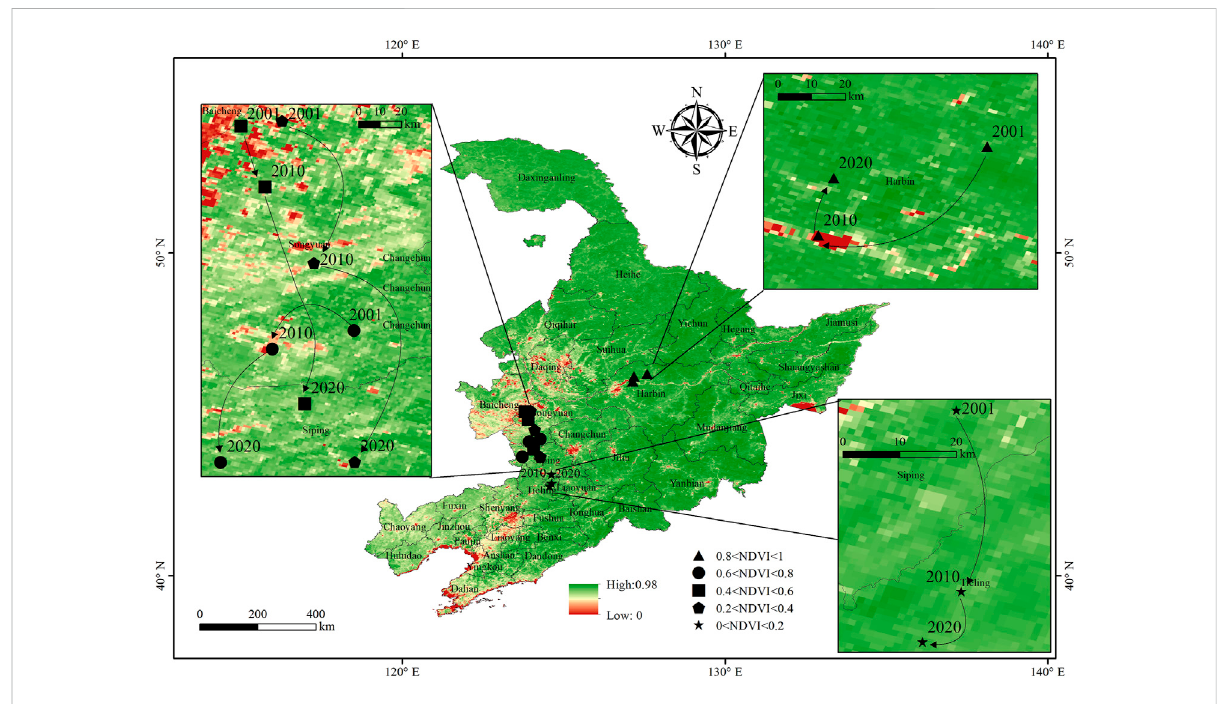
FIGURE 5 Center of gravity migration of different vegetation coverage in the three northeast provinces from 2001 to 2020.